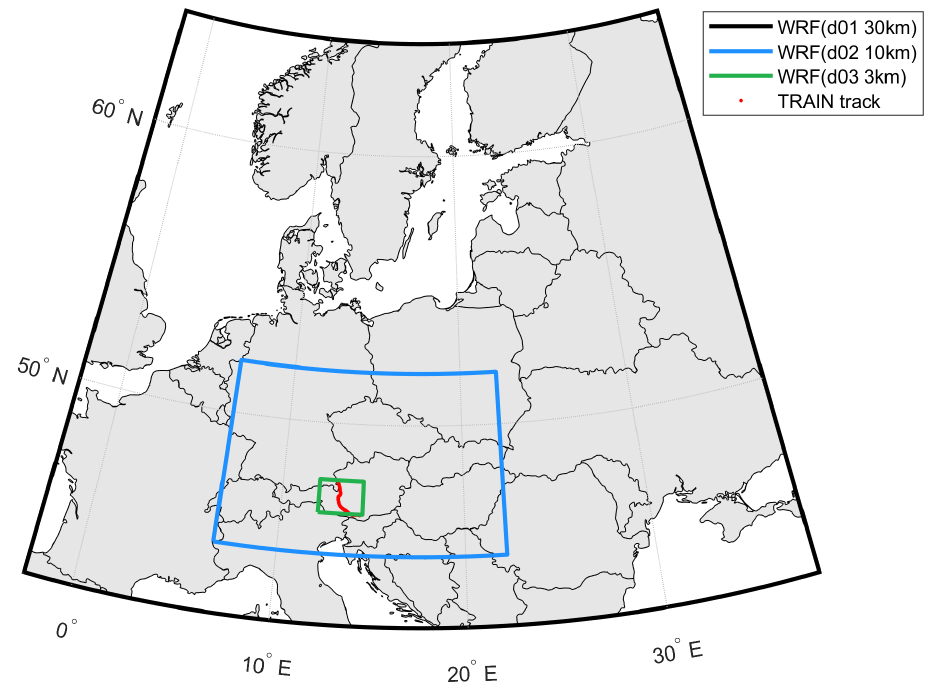
Figure 2. Overview over the defined WRF domains utilized for the assimilation experiments, shown for the first test case exemplary.